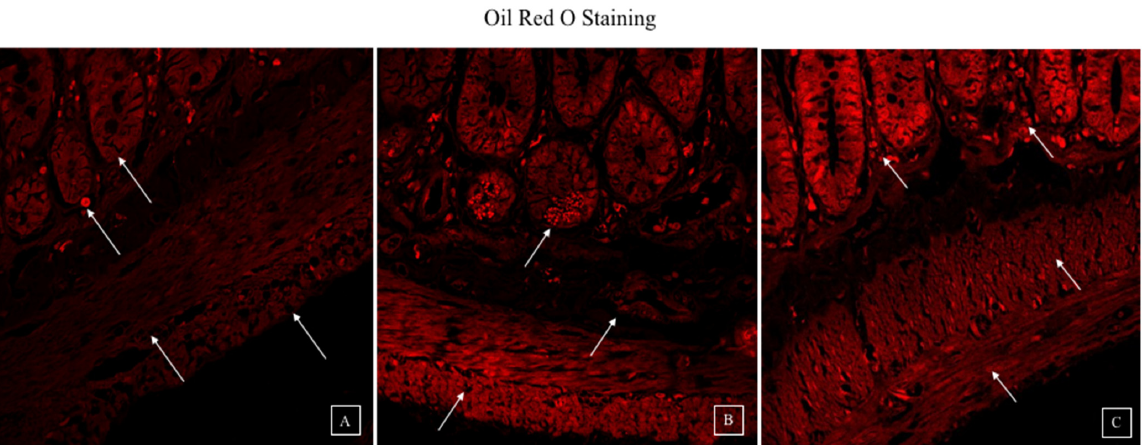
Figure 6. Confocal images of lipogenesis staining by Oil red O as standard and C2 stain is the novel lipid stain ( A ) control rats ( B ) rats exposed to 100 ethanol in increasing amounts ( C ) rats administrated with ethanol and synbiotic (10 9 CFU/day L. rhamnosus MTCC1423 and 200 mg/kg AGE). The staining of lipid droplets (ethanol group), disruption of the colon epithelial layer in the presence of ethanol, and regaining of the epithelial barriers in the company of the two treatments (AGE and synbiotic) are represented by arrows.